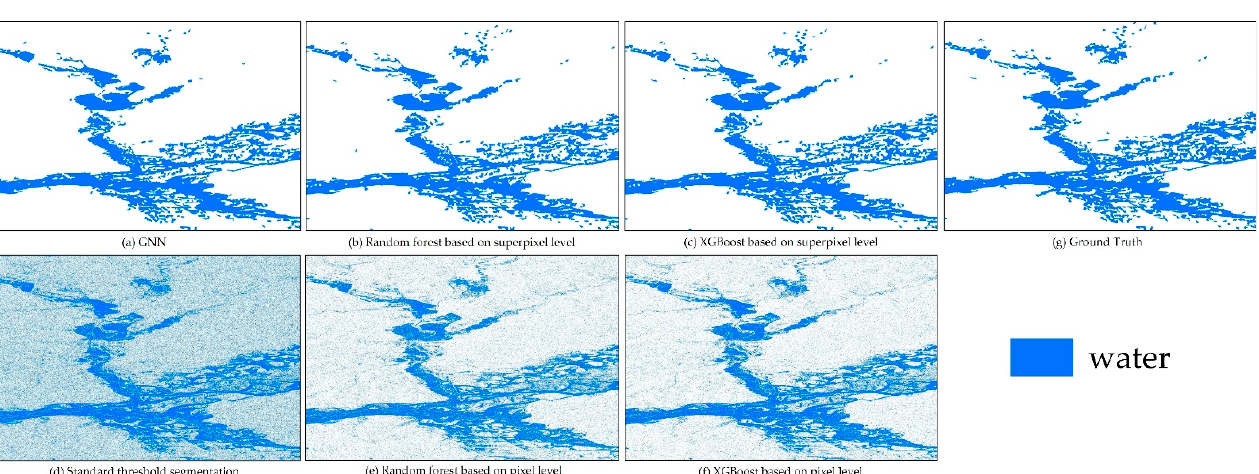
Figure 9. Constructed graph data from image. ( a ) Superpixels on the PolSAR image; ( b ) visualiza- tion of graph data.